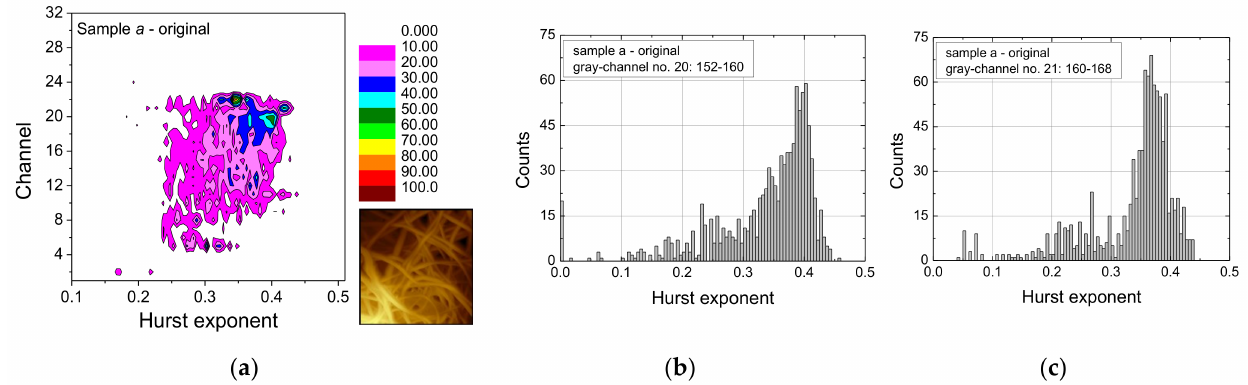
Figure 5. ( a ) Gray-scale-resolved Hurst exponent distribution of sample a in the original version, with the color-code giving the counts of the included histograms; ( b ) classical distribution for channel 20; classical distribution for channel 21 ( c